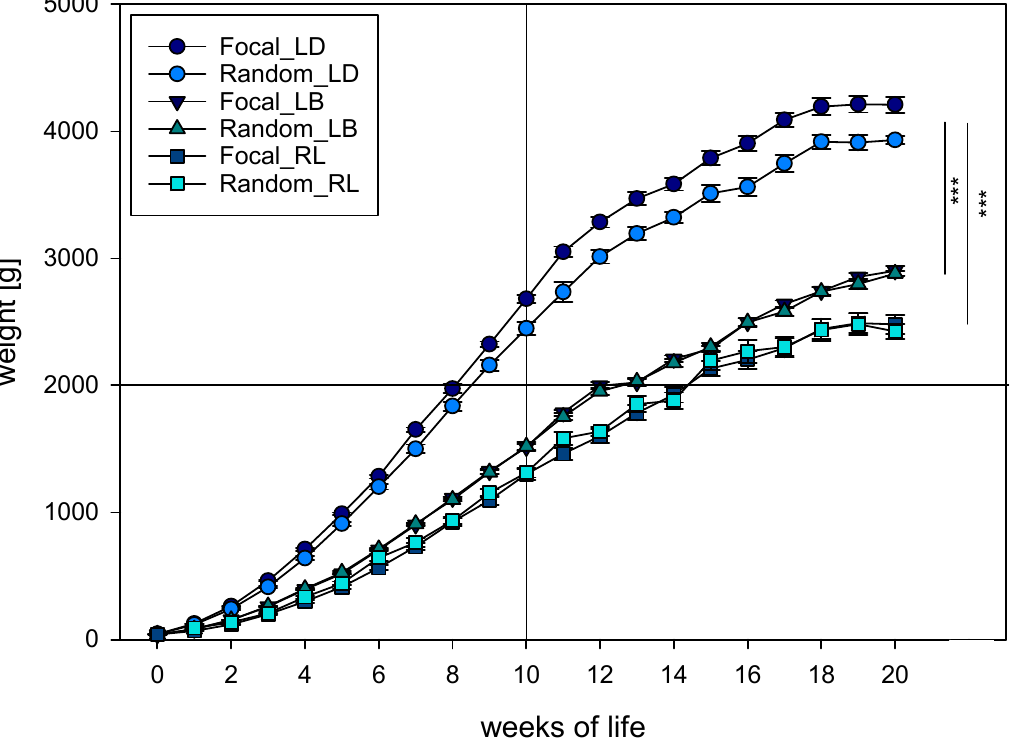
Figure 1. Growth rates (g) of cockerels of commercial dual-purpose hybrid Lohmann Dual (LD), commercial layer hybrid Lohmann Brown (LB), and native purebred breed Rhinelander (RL) until the 21st week of life. Shown are means ± SE of focal and random sample groups; significant differences are indicated with stars (*** for p ≤ 0.001). Indicated are reference lines for 10 weeks of life and 2000 g live weight.